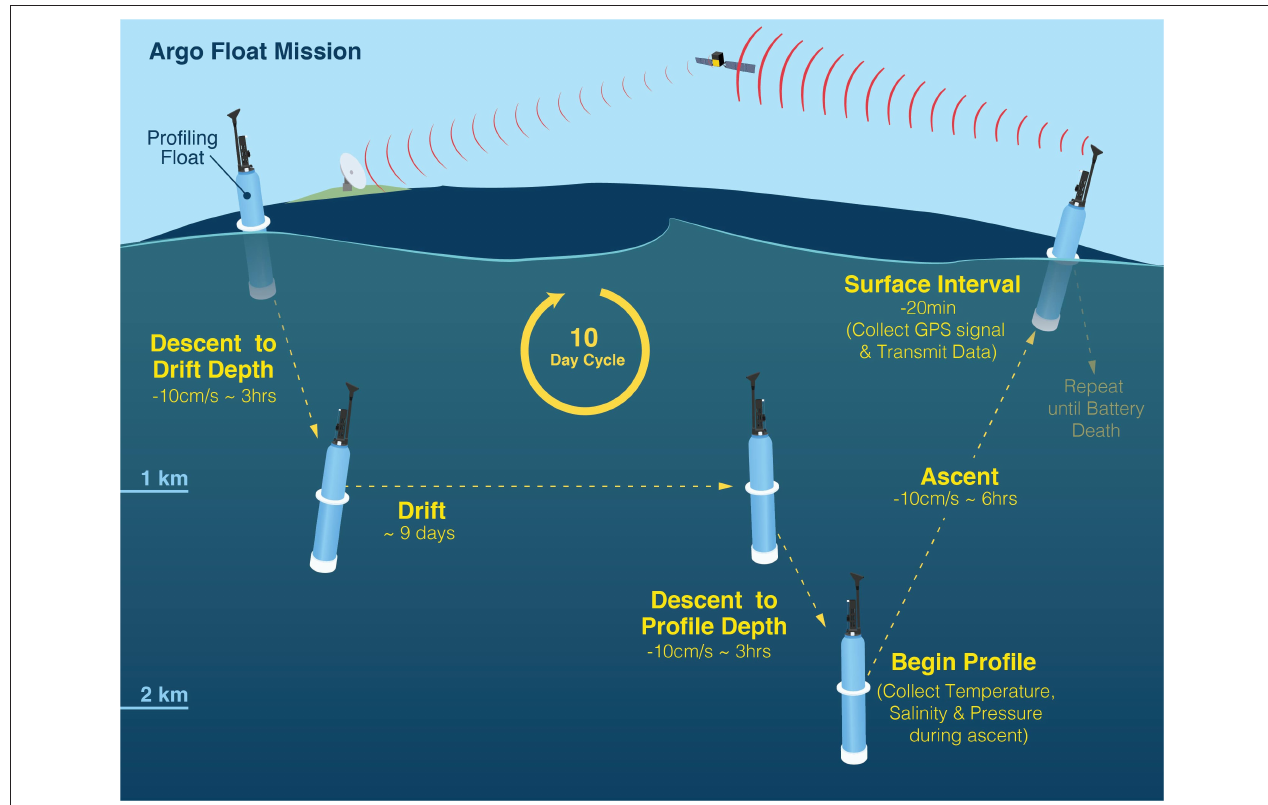
FIGURE 1 | A schematic illustration of the standard Argo “park-and-profile” mission. The surface interval of ∼ 20min is applicable to floats that use Iridium satellite communication; floats that use ARGOS satellite communication require surface interval of several hours for data telemetry. [Source: Woods Hole Oceanographic